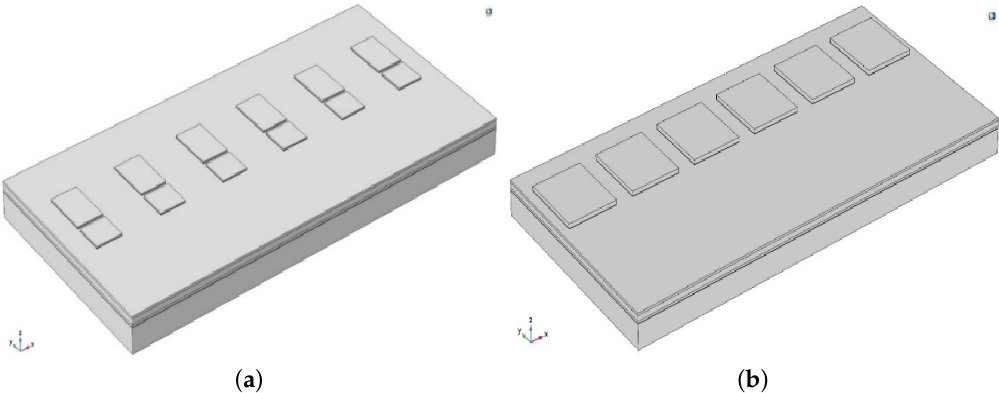
Figure 16. 3D view of MOSFET modules: ( a ) for Si; ( b ) for GaN.